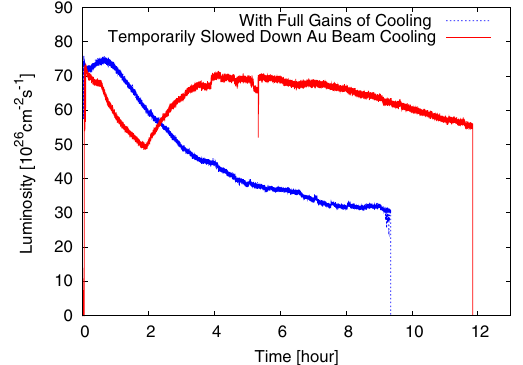
FIG. 17. Comparison of luminosities of the two example fills without and with cooling rate adjustment (as shown in Fig. 13 and Fig. 16). The integrated luminosity per store increased by 74% with cooling gain